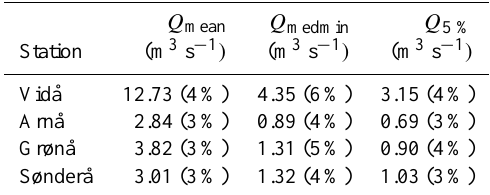
Table 8. Stream flow indicators for the future scenario (DBS method) with increased atmospheric CO 2 . Changes relative to the DBS scenario without increased CO 2 , Table 7, are presented in